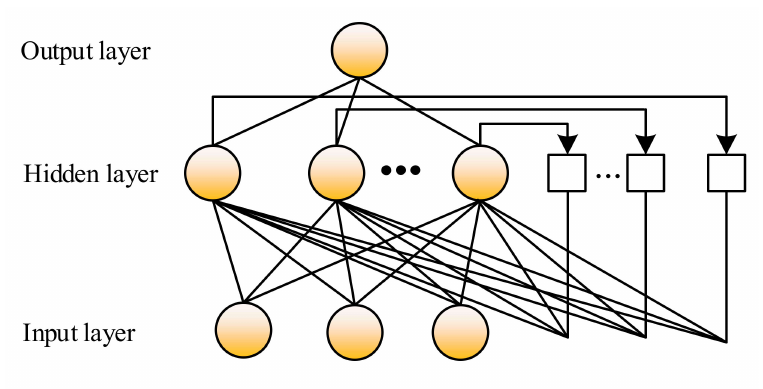
Figure 15. Structure of SLFN [63].